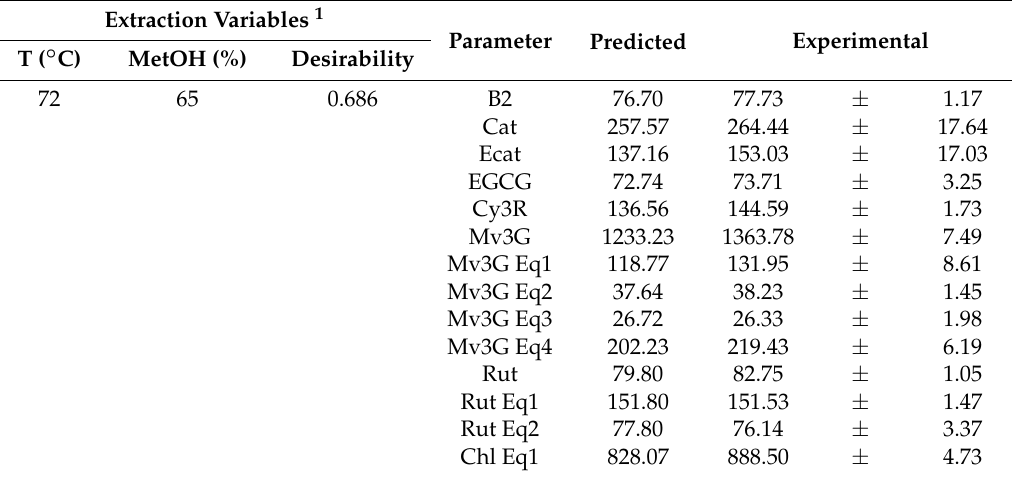
Table 3. Overall optimal values of extraction parameters for flavanols, anthocyanins, flavonols, and phenolic acids of organic whole red Grenache